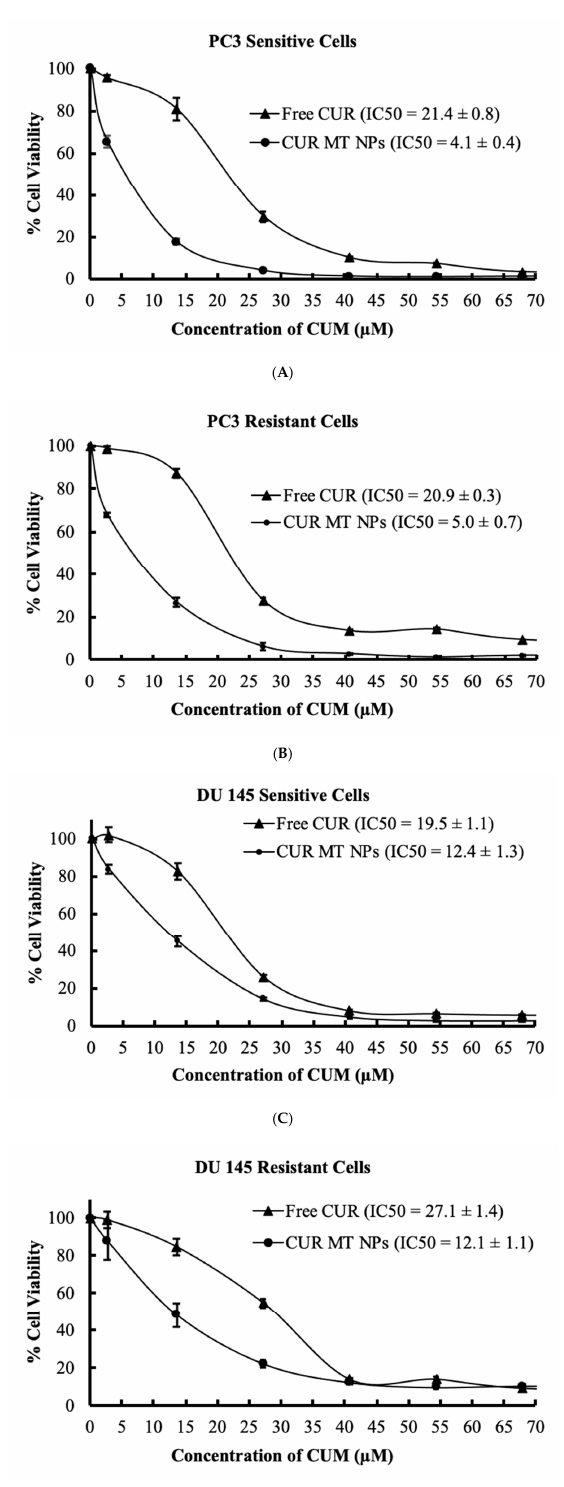
Figure 6. Cytotoxicity studies of CUR and CUR MT NPs in castration-resistant prostate cancer (CRPC) cells. ( A ) DTX-sensitive PC3 cells, ( B ) DTX-resistant PC3 cells, ( C ) DTX-sensitive DU145 cells, and ( D ) DTX-resistant DU145 cells. Data are presented at the mean of three independent measurements ( n = 3) ± SD. Cells were treated for 72 h with samples. Cell viability was measured by 3-(4,5-dimethylthiazol-2-yl)-2,5-diphenyltetrazolium bromide (MTT)